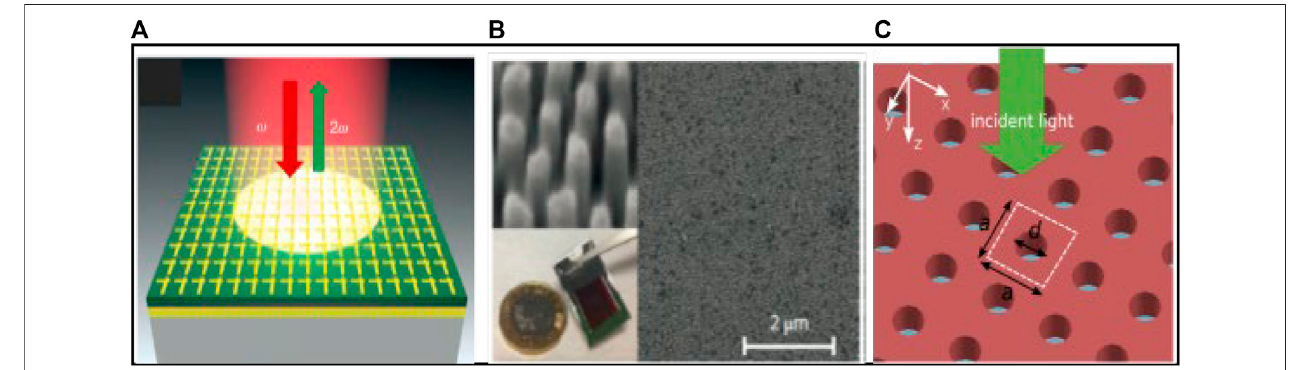
FIGURE 9 | Nonlinear metasurface and power recon fi gurable metasurface [136 – 138].